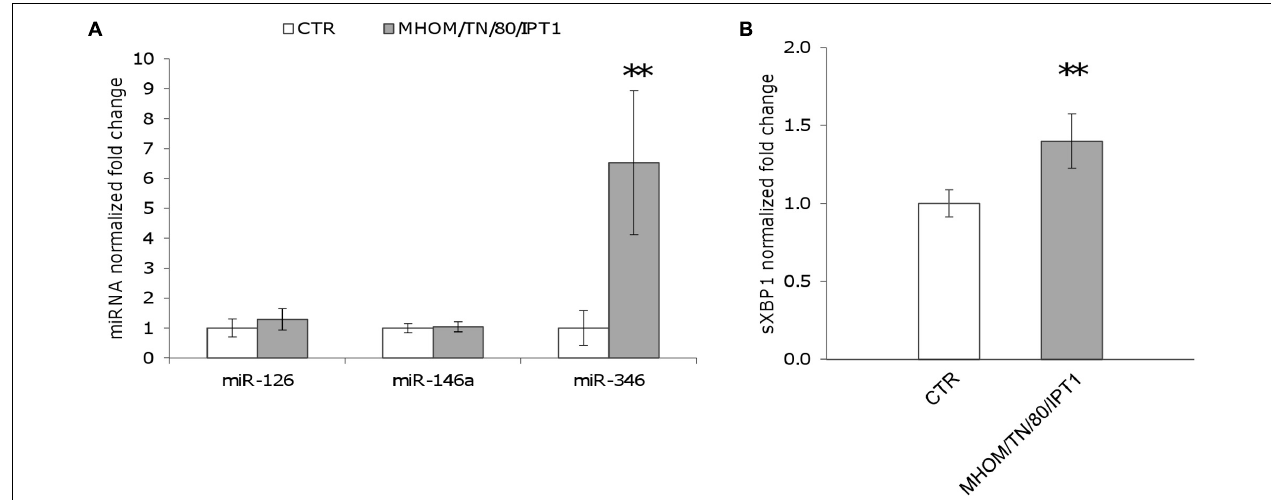
FIGURE 2 | miR-346 is upregulated in U937-derived macrophages infected with L. ( L. ) infantum. (A) miR-126, miR-146a, and miR-346 expression in cells infected for 24 h with L. ( L. ) infantum MHOM/TN/80/IPT1 strain (gray bars) relative to control cells (white bars). (B) sXBP1 expression in infected cells (gray bars) compared to control cells (white bars). Data are represented as the mean ± SD of two experiments ( n = 4). CTR: non-infected cells. ∗∗ p < 0.01.